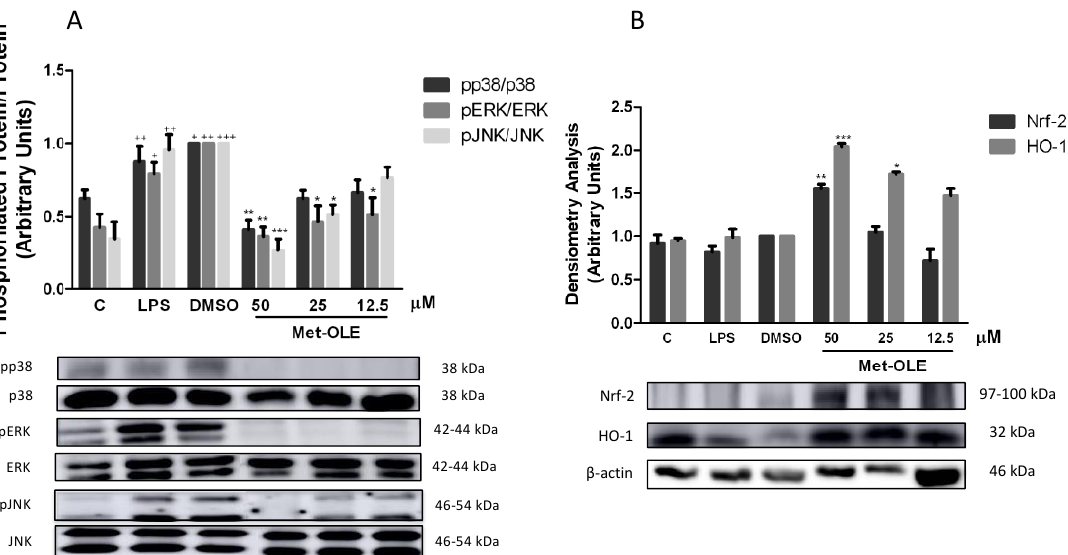
Figure 5. Met-OLE inhibited ( A ) MAPKs phosphorylation and ( B ) upregulated the Nrf-2/HO-1 antioxidation axis in LPS-induced cells. Macrophages were pretreated and stimulated with LPS during 18 h with met-OLE (50, 25 or 12.5 µ M). Subsequently, MAPKs, Nrf-2, and HO-1 protein expressions were measured in whole cell lysates by Western blot. Results are presented as the mean ± SEM of at least six independent experiments. + p < 0.05; ++ p < 0.01; +++ p < 0.001 vs. unstimulated control cells; * p < 0.05; ** p < 0.01; *** p < 0.001 vs. LPS-DMSO stimulated cells.